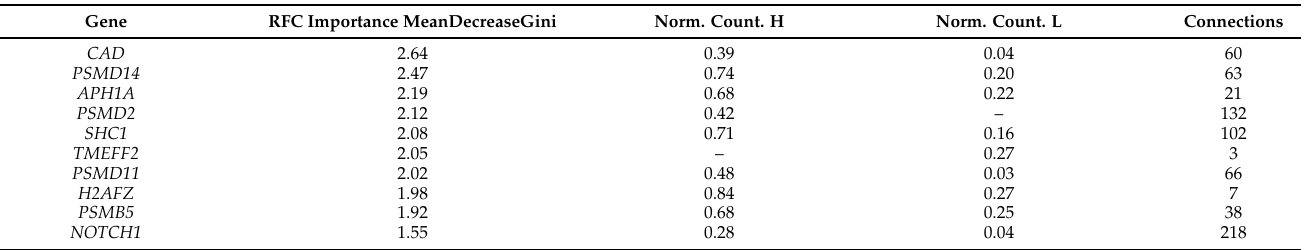
Table 4. Gene contribution to the RFC classification of samples from the H and L classes ordered by decreasing importance according to their mean decrease in Gini